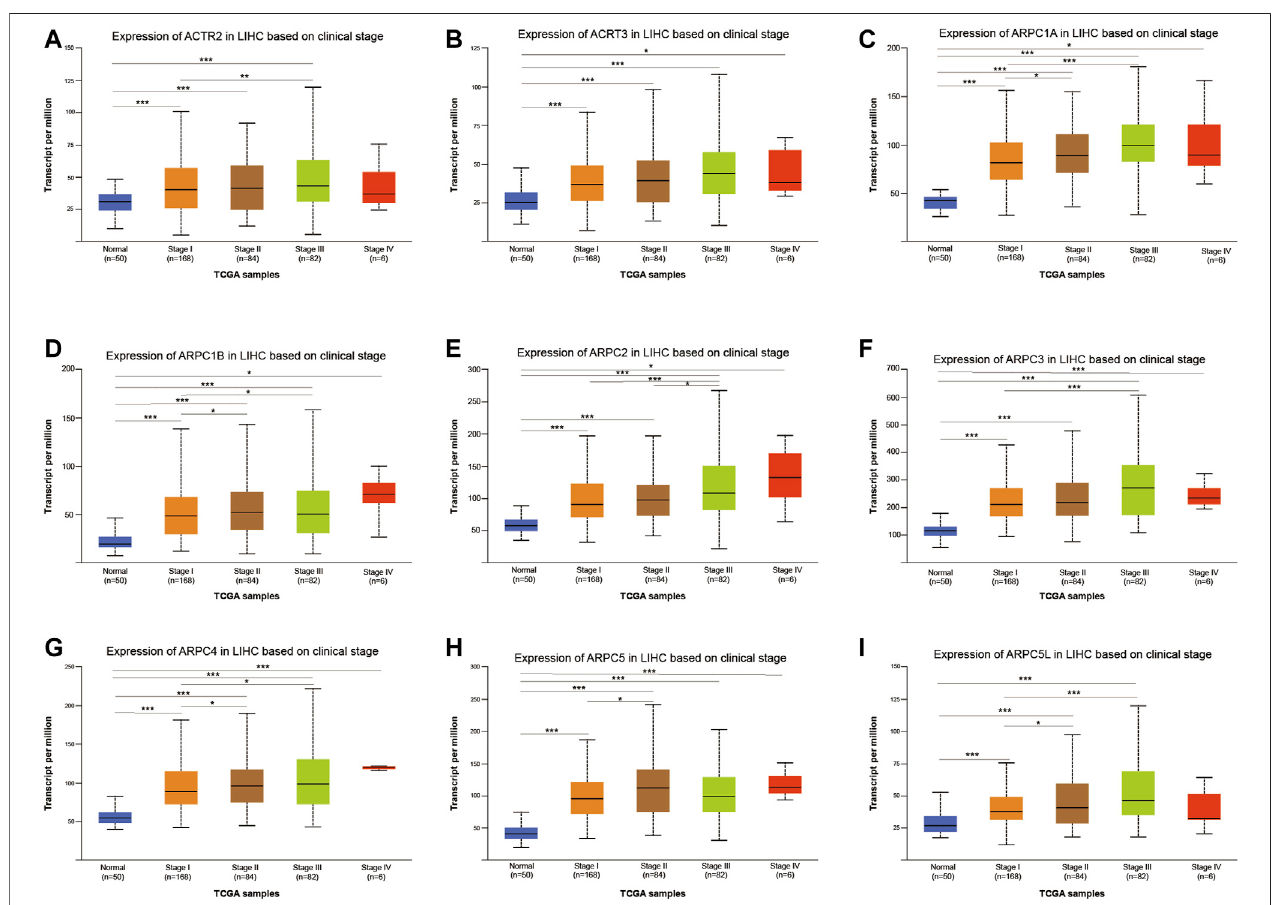
FIGURE 10 | Analysis of association between mRNA expression of Arp2/3 members and cancer stages of HCC patients (A – I) . The mRNA expression of Arp2/3 members in normal individuals or in HCC patients of stages I, II, III, or IV. * p < 0.05; ** p < 0.01; *** p < 0.001.